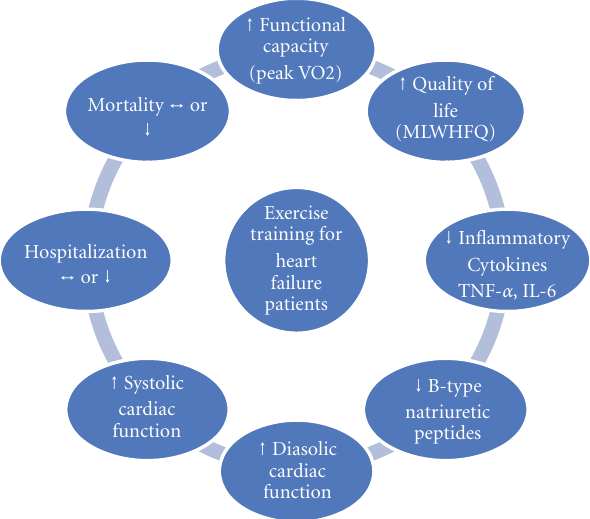
Figure 3: Clinical or prognostic markers of change in heart failure patients undertaking exercise